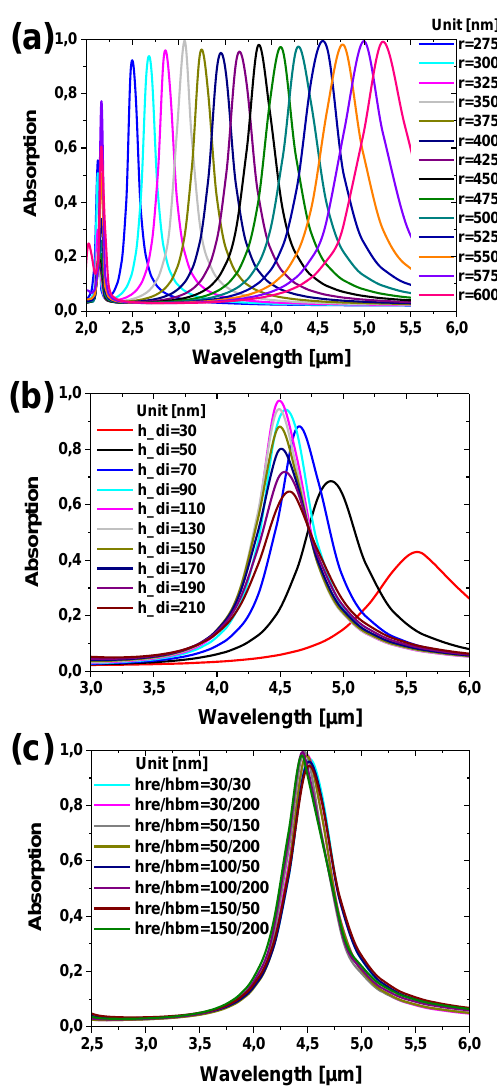
Figure 3. Numerical calculations of absorption spectra for varying (a) resonator radius, (b) dielectric layer thickness, and (c) resonator (hre) and bottom metal (hbm)